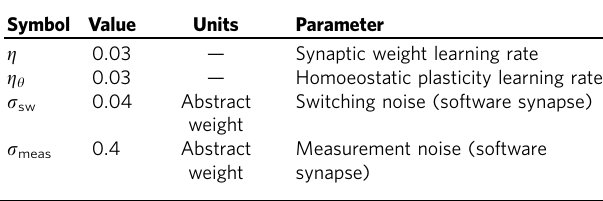
Fig. 1e. Using equations (1) and (2) we find Table 1 | Key ANN operating